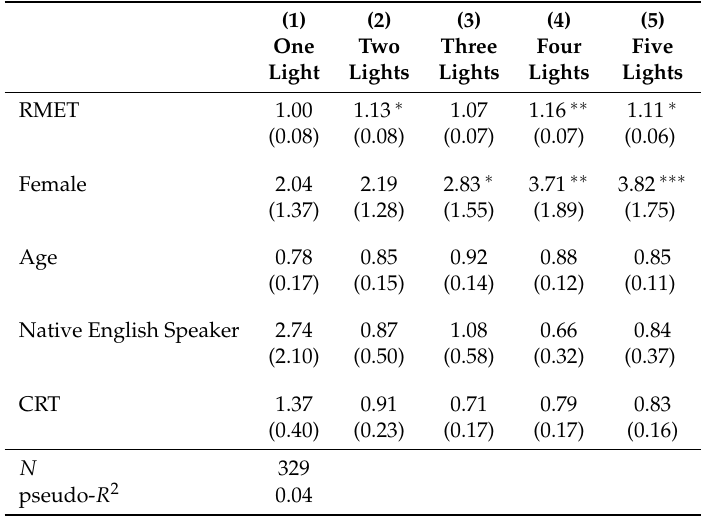
Table A6. Predicting Number of Lights by ToM: Multinomial Logit